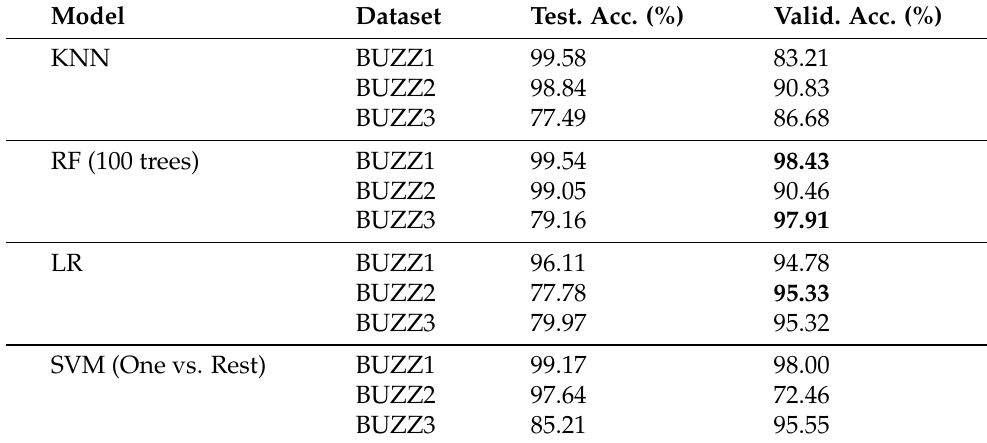
Table 4. Model accuracies with 13 MFCCs; best validation accuracies are in bold.